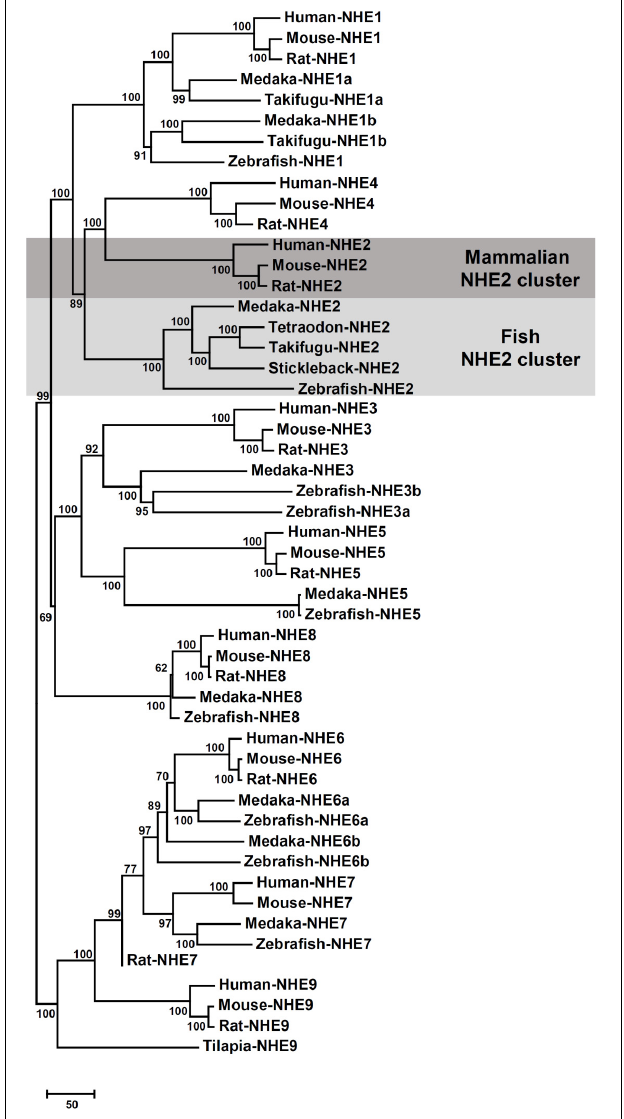
FIGURE 1 | Phylogenetic tree based on comparisons of Na + /H + exchanger (NHE) sequences. Putative sequences of amino acids in medaka ( Oryzias latipes ) and other species were collected from NCBI and Ensembl databases (listed in Supplementary Table 1 ). The Neighbor-joining method was used to build the phylogenetic trees of NHEs and confirmed by 1000 bootstraps. The unit of the scale bar represents the number of substitutions per